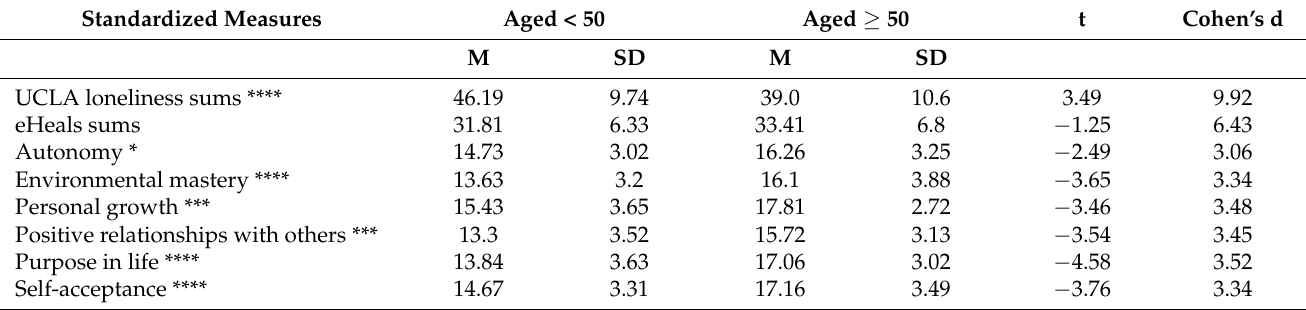
Table 5. Results of t -tests comparing survey respondents aged under 50 and aged 50 and over on standardized measures of loneliness (UCLA) eHealth literacy (eHeals) and wellbeing (Psychological